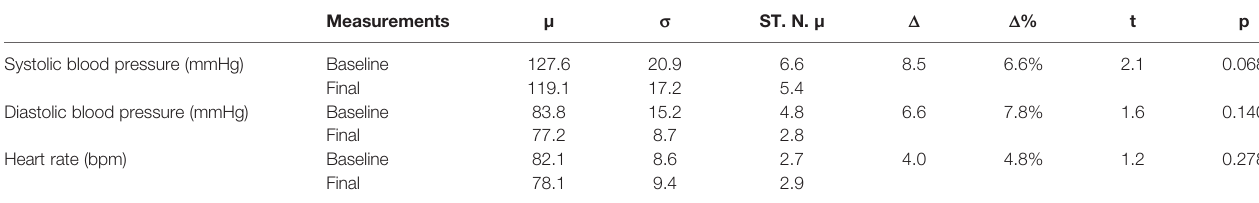
TABLE 2 | Comparison between baseline and fi nal measurements of hemodynamics. Measurements